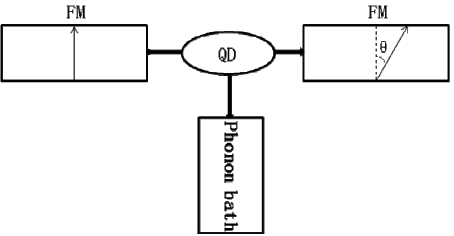
Figure 1. Schematic diagram of a quantum dot (QD) coupled to two ferromagnetic leads and phonon reservoirs. The magnetizations between the left and the right ferromagnetic (FM) leads deviate by angle θ